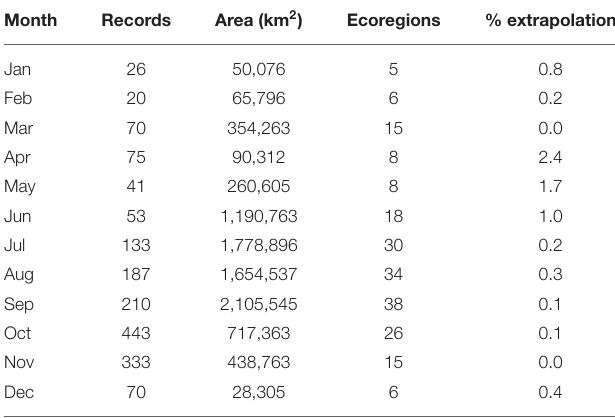
TABLE 3 | Number of records, suitable area, number of ecoregions intersected by predicted suitable area and percentage of predicted suitable area where model extrapolation occurs for the monarch butterfly migratory route.